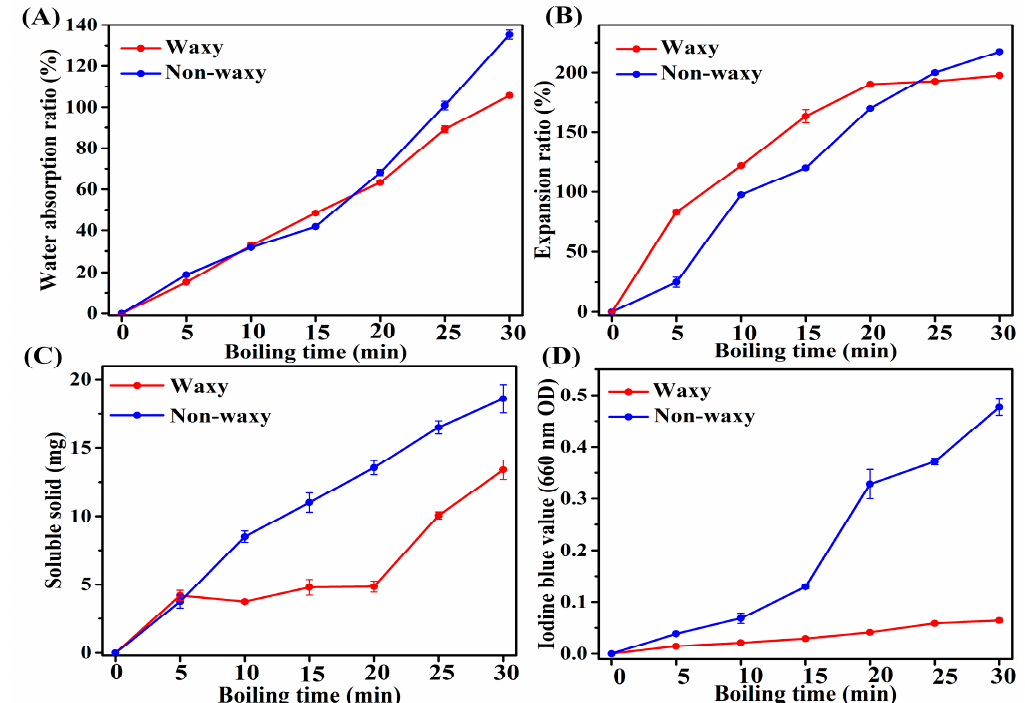
Figure 3. Cooking characteristics of proso millet. ( A ) Water absorption ratio, (B) expansion ratio, ( C ) soluble solid, and ( D ) iodine blue value, respectively.